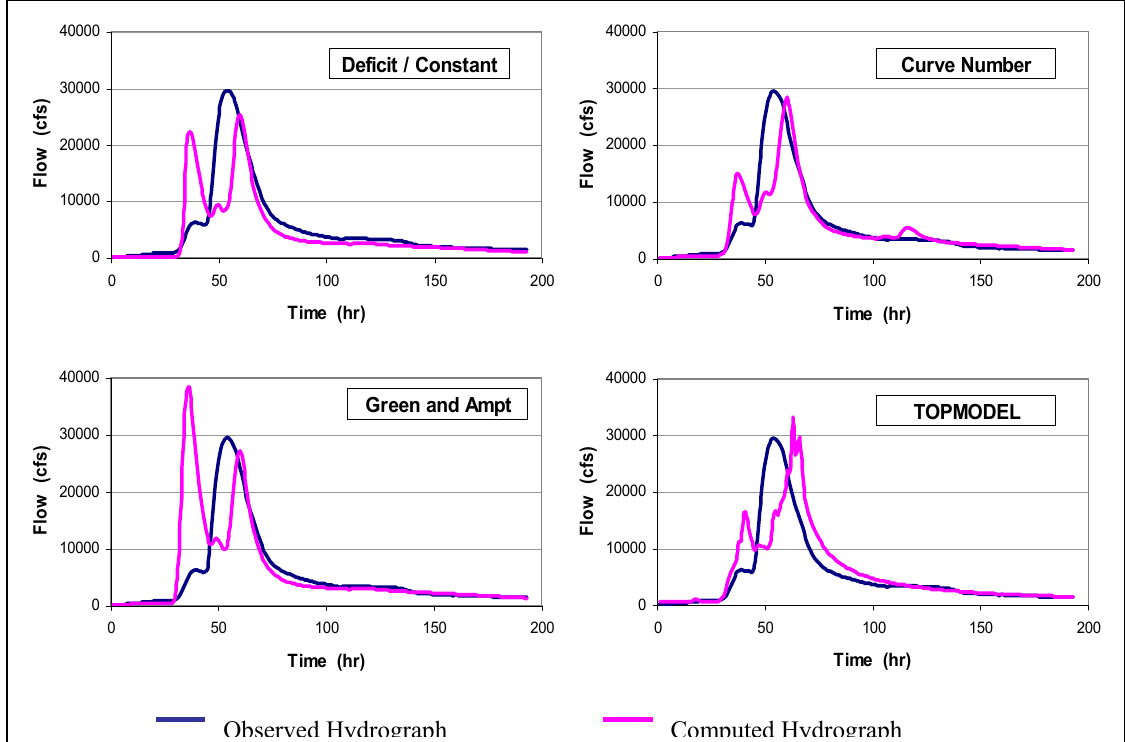
Figure 7. Computed vs. Observed Hydrographs using actual satellite rainfall data (adjusted) at the native scale of 0.25 o